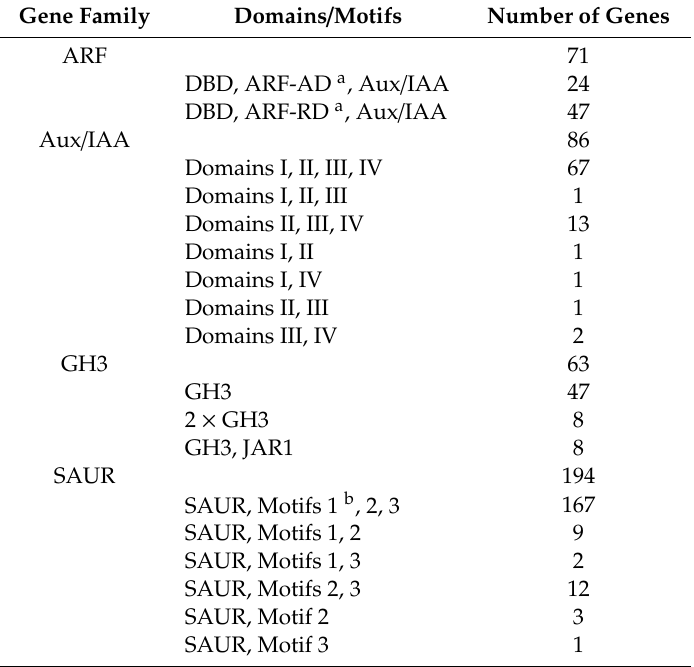
Table 1. Characteristics of identified auxin response factor (ARF), Auxin / Indole-3-Acetic Acid (Aux / IAA), Gretchen Hagen3 (GH3), and small auxin upregulated RNA (SAUR) genes in upland